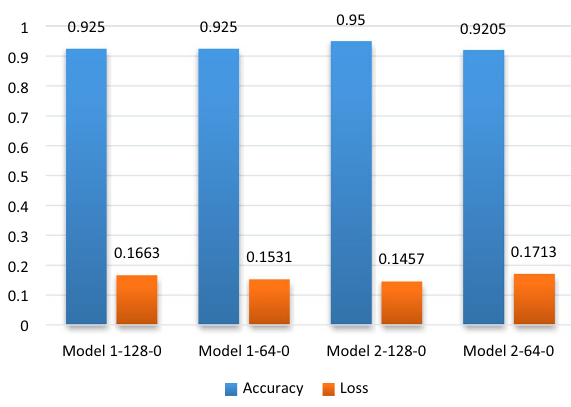
Figure 11. Performance of the models based on evaluation metrics.